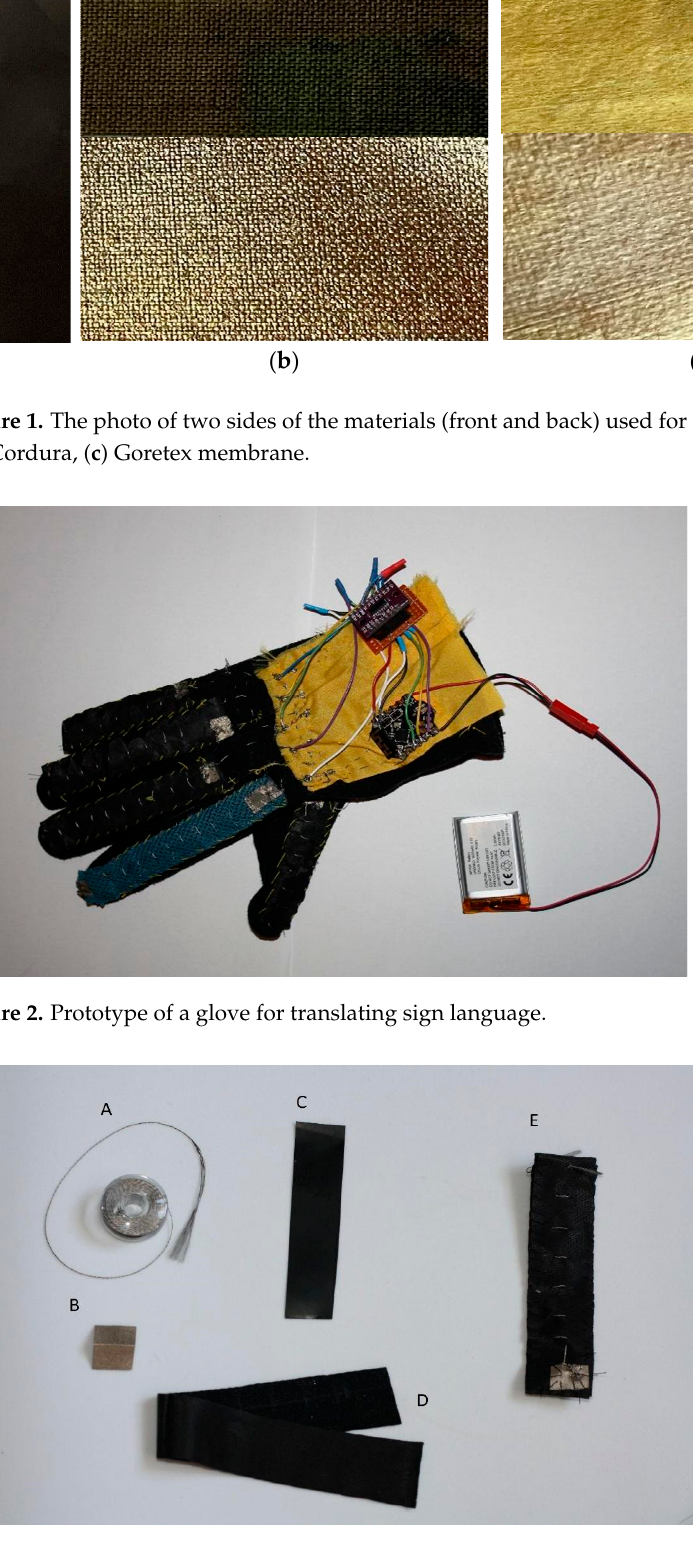
Figure 3. The bend sensor ( E ) and its components—conductive thread ( A ) and material ( B ); Velostat ( C ) as the core, and a piece of fabric ( D ).